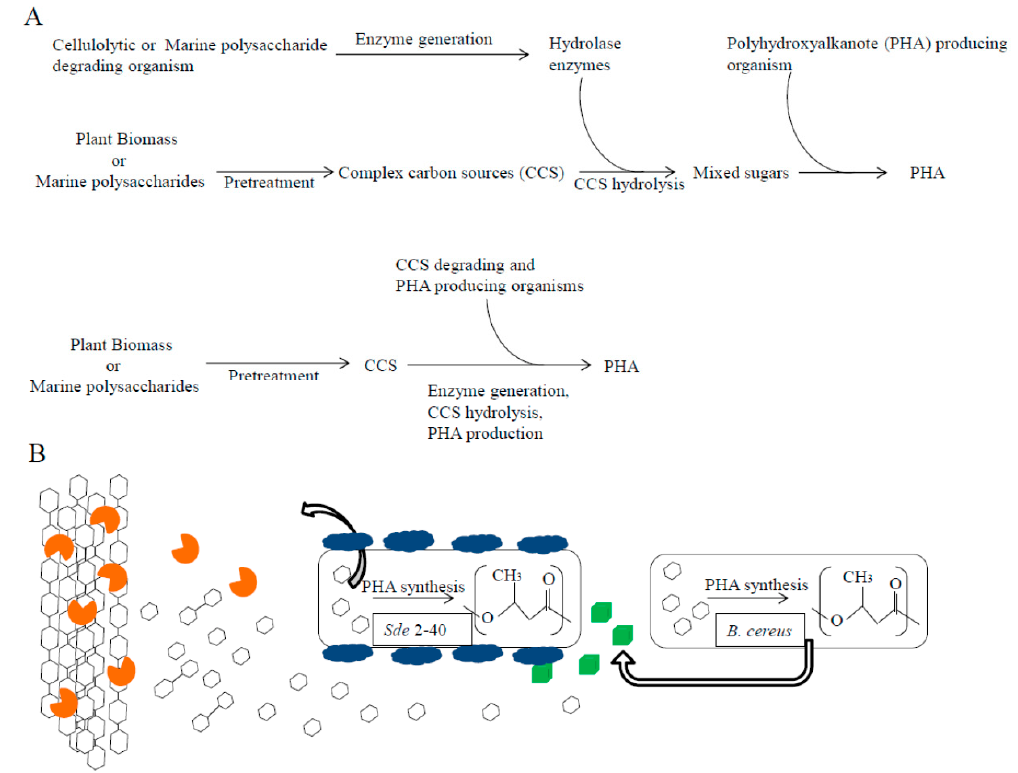
Figure 1. Consolidated bioprocessing of plant biomass or marine polysaccharides to polyhydroxyalkanoates (PHAs) by Sde 2-40 and co-culture of Sde 2-40 and B. cereus. ( A ) Production of PHA by two processes. Classically, sugars are generated from biomass using enzymes with the ability to hydrolyse cellulose and hemicellulose, and PHA is produced by microbes (top). Enzyme production, hydrolysis of biomass, and production of PHA is carried out in single stage in consolidated bioprocessing (bottom); ( B ) Pure and co-culture of microorganisms applied to enhance agarose utilization and PHA production from xylan and agarose. Complex carbon sources are hydrolysed by secreted hydrolase enzymes (orange) to soluble sugars, which are further metabolized to PHA. Cadherin and cadherin-like domains on Sde 2-40 cell surface (blue) mediate cell to cell contact. B. cereus produce metabolites (green), which may stimulate the growth of Sde 2-40.